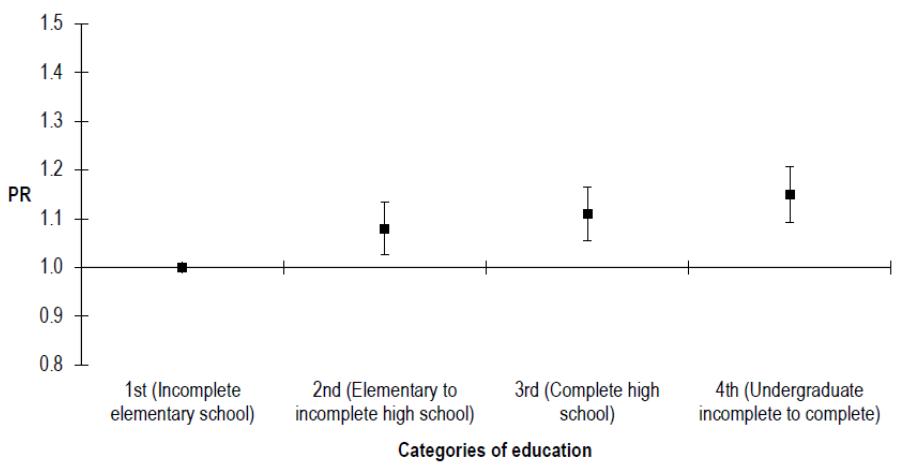
Figure 2. Prevalence ratio (PR) for bicycle ownership according to education and adjusted by age and sex. Table 2. Distribution of facilities according to participants’ residence.